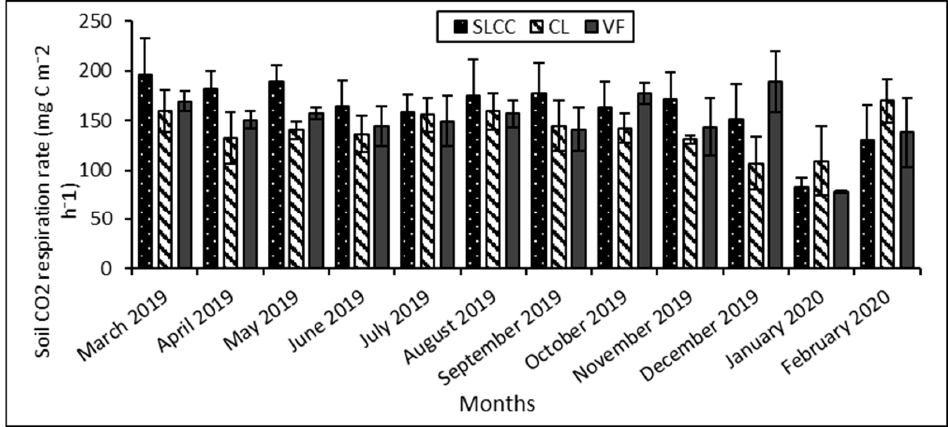
Figure 4. Mean monthly soil respiration (mg C m − 2 h − 1 ) measurements in supervised logging with climber cutting areas (SLCC), conventional logging areas (CL), and virgin forest areas (VF) at Gunung Rara Forest Reserve, Sabah, Malaysia, from March 2019 to February 2020. Error bars represent the standard error for the measurements.